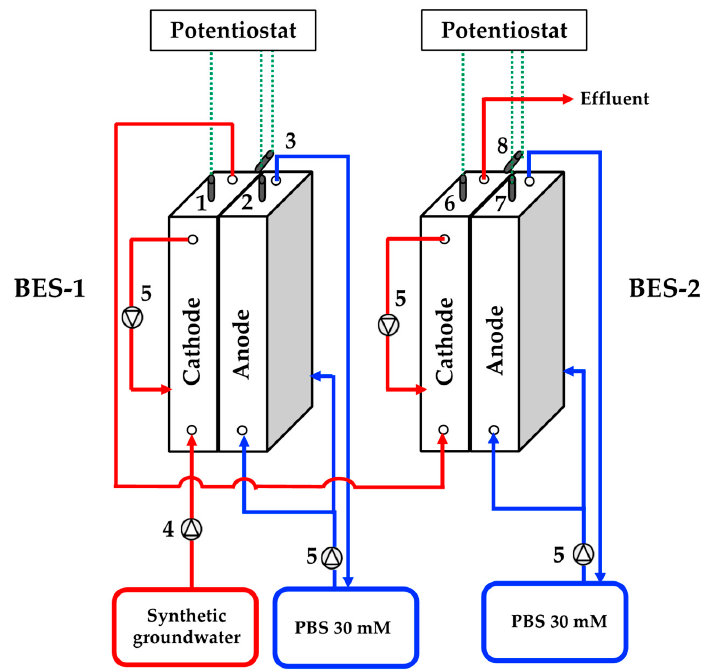
Figure 1. Two stage BES for nitrate removal: liquid and electric schemes: anodic circuit: red lines; cathodic circuit: blue lines; electric circuits: dashed lines. Legend: (1)(6) cathode (working) electrodes; (2)(7) anode (counter) electrodes; (3)(8) Ag / AgCl reference electrodes; (4) feeding pump; (5) recirculation pumps.